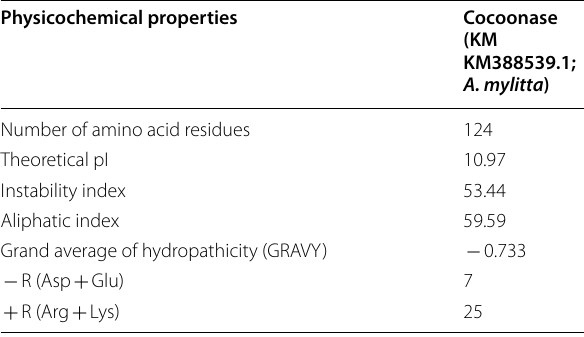
Table 5 Physicochemical parameter of cocoonase computed